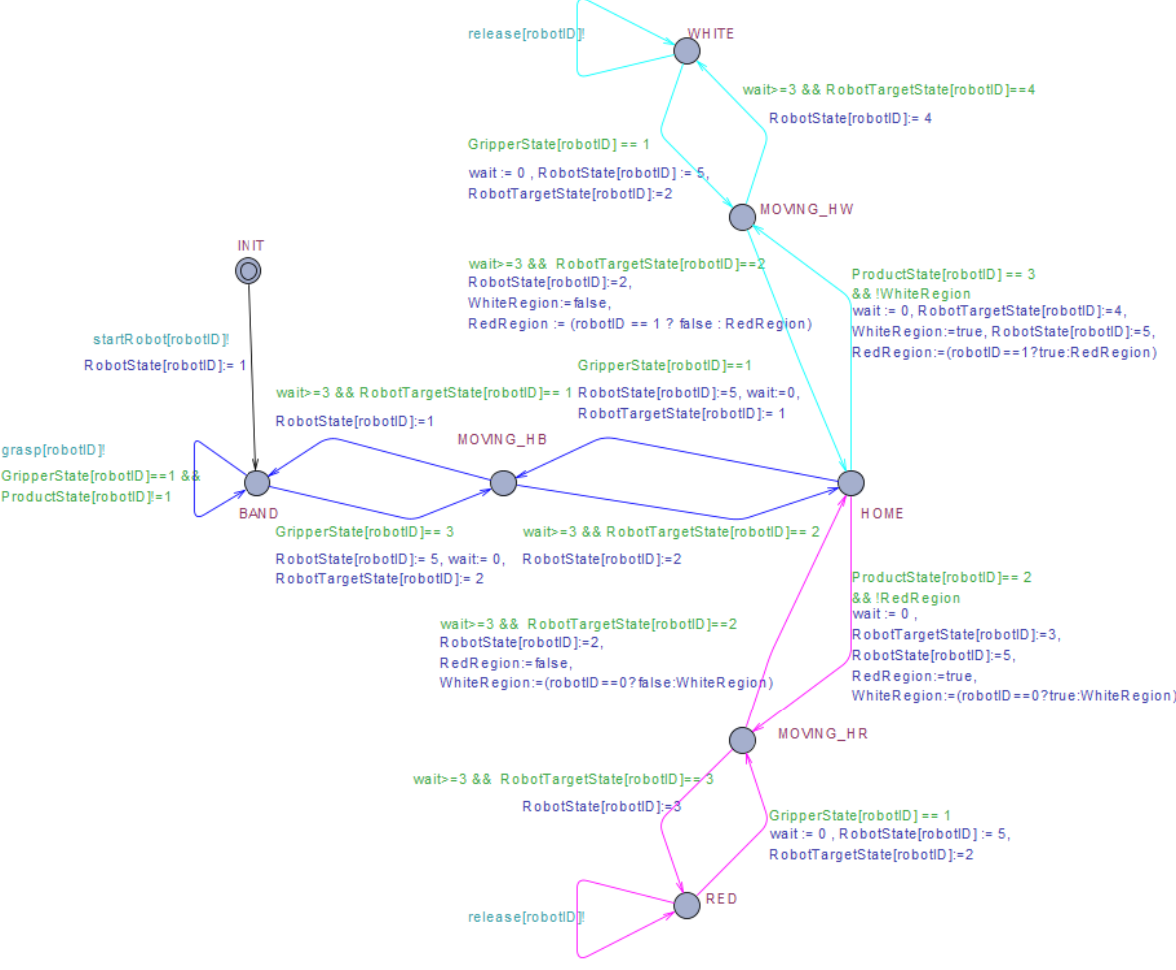
Figure 6. UPPAAL timed automata model of the robot controller.